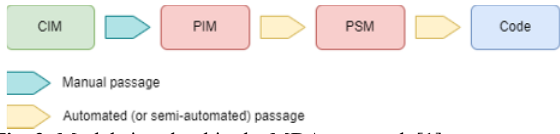
Fig. 2. Models involved in the MDA approach [1]